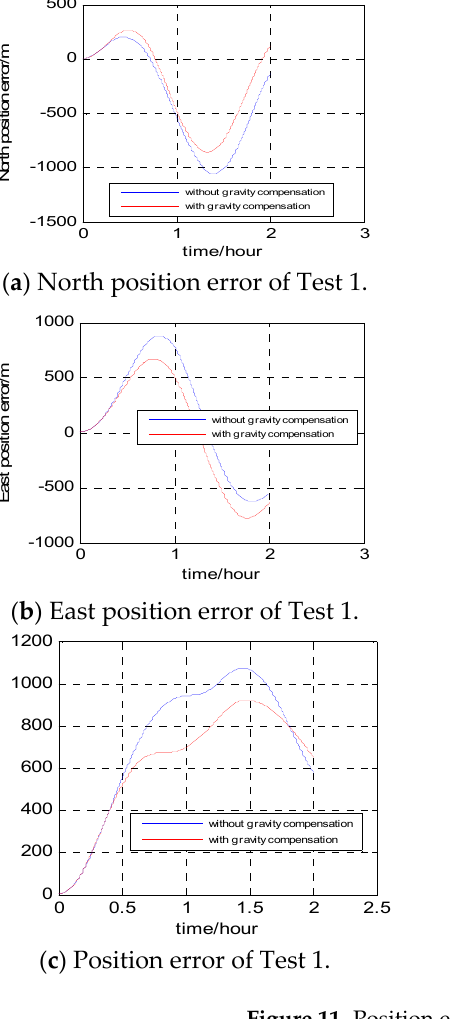
Figure 11. Position errors of the two tests.